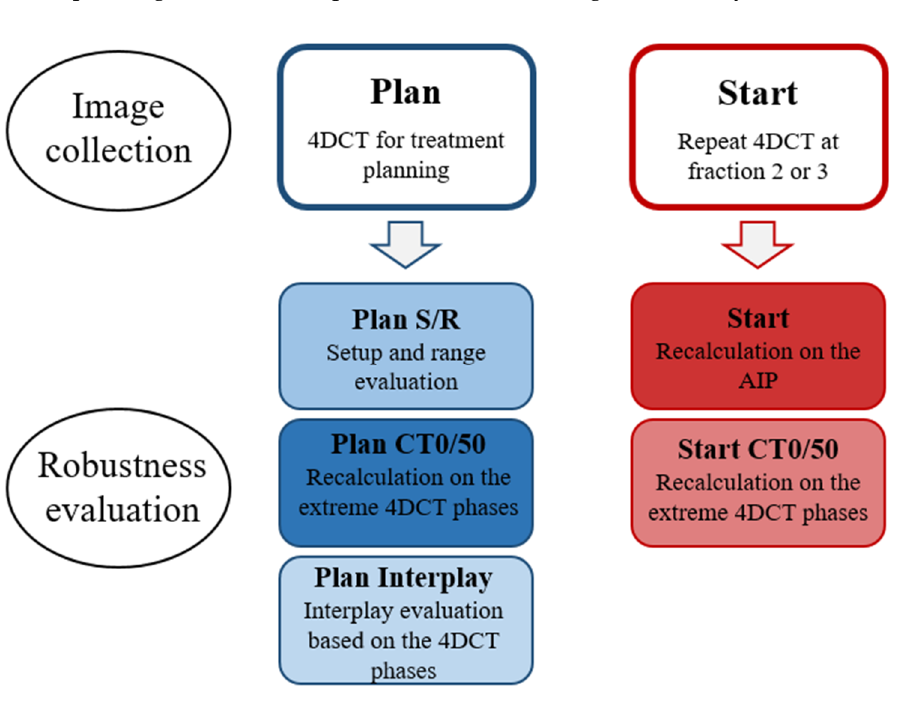
Figure 1. Overview of the acquired image data and the robustness